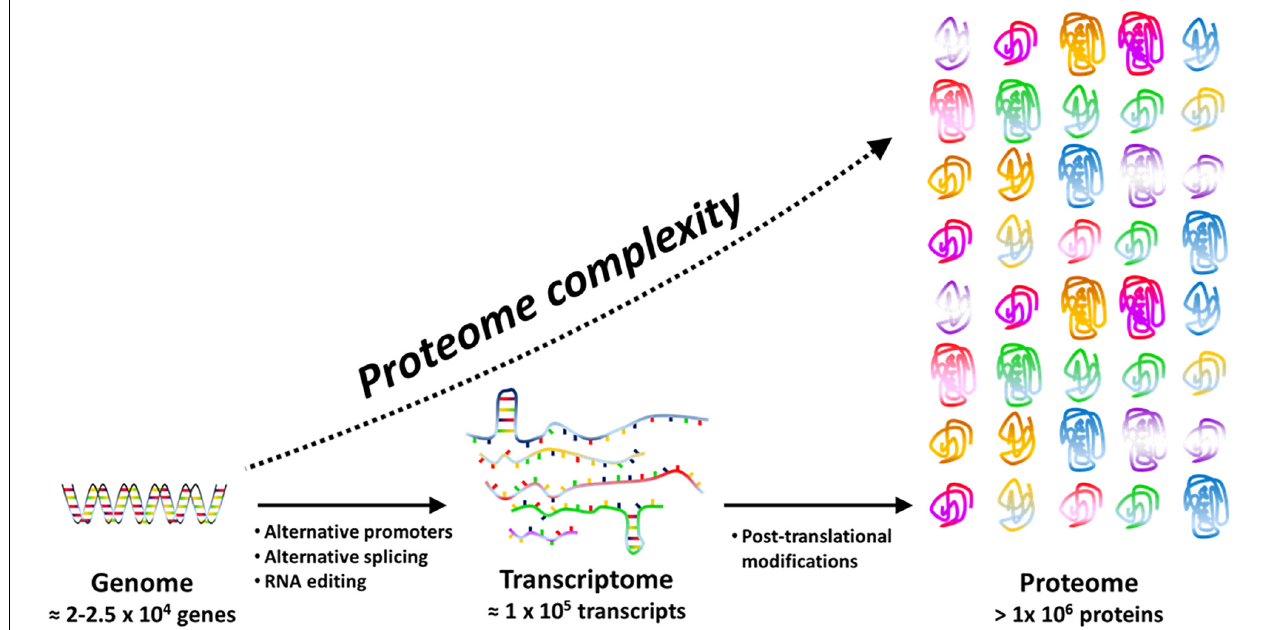
FIGURE 1 | Proteome complexity is the result of transcriptional (e.g. alternative promoters), post-transcriptional (e.g. RNA editing and splicing) and post-translational events. Post-translational events include a large panel of reversible or irreversible chemical modifications that may affect structure, function and cellular location of